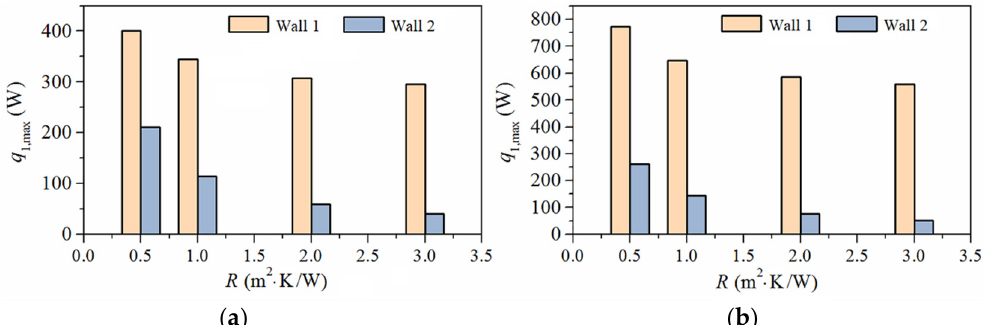
Figure 9. Comparison of the peak transmission load between the two walls with respect to di ff erent insulation resistance; ( a ) in cooling season; ( b ) in heating season.